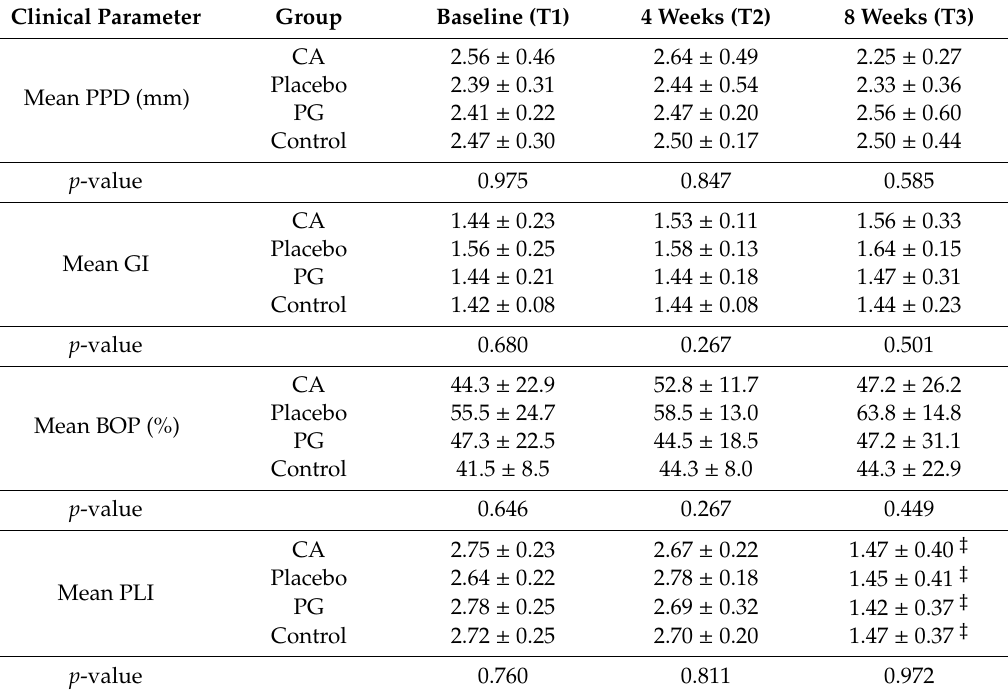
Table 1. Clinical parameters (mean ± S.D.) measured at di ff erent time